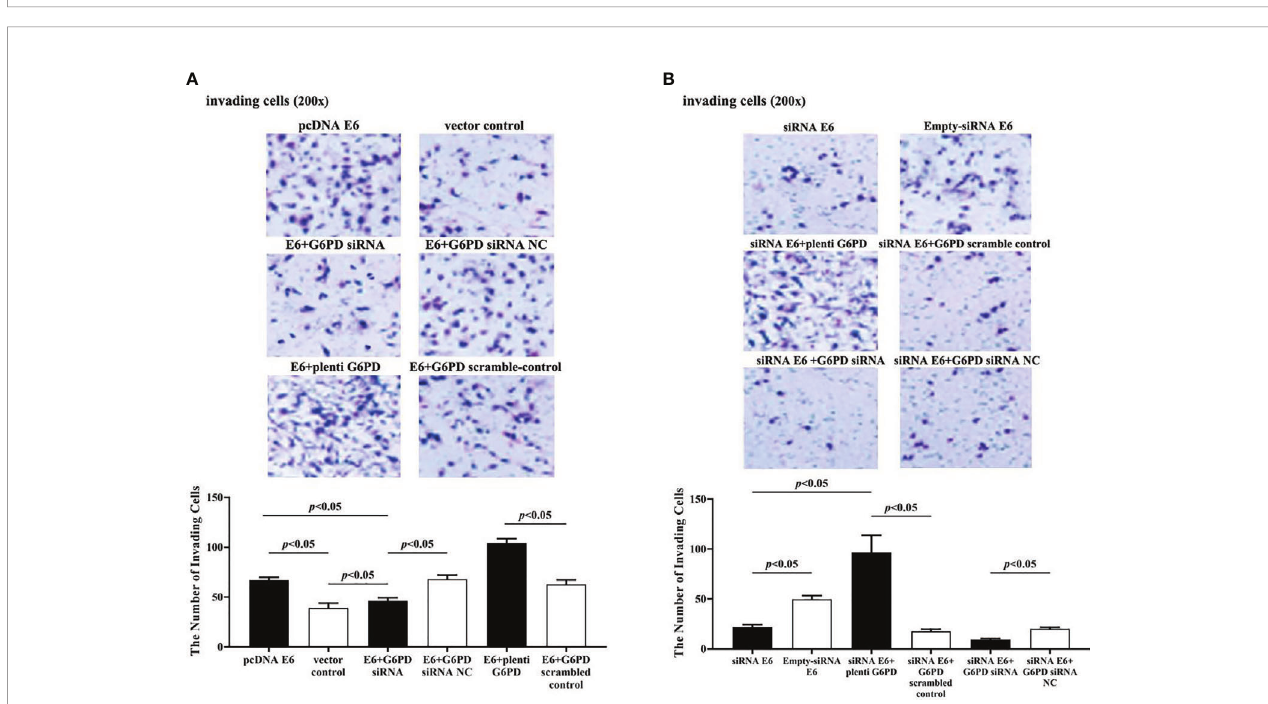
FIGURE 10 | HPV16 E6 facilitates the invasion of HeLa cells through G6PD.The staining of invaded cells with different plasmid transfection was observed under a microscope (200×). (A, B) Representative photographs and statistical plots of the quanti fi cation of invading cells from six different treatment groups. Data are presented as means ± SD (n =